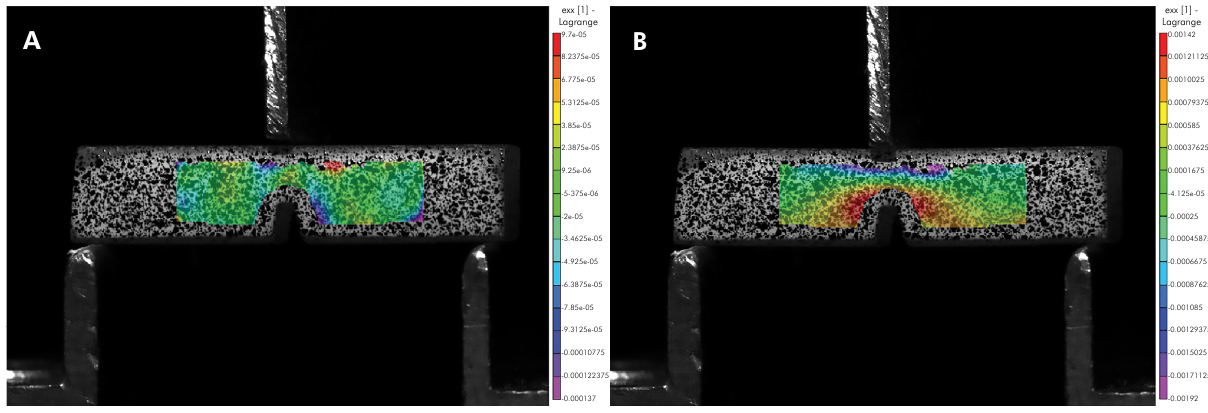
Figure 5. (a) Nanofilled resin material is characterized by scattering the strain due to plastic behavior. The initial compression can be seen just below the machine device. (b) At the moment just before the fracture scattering of the tensile stress is around the v-notch similar to the lithium disilicate glass ceramic showing that of unexpected plastic